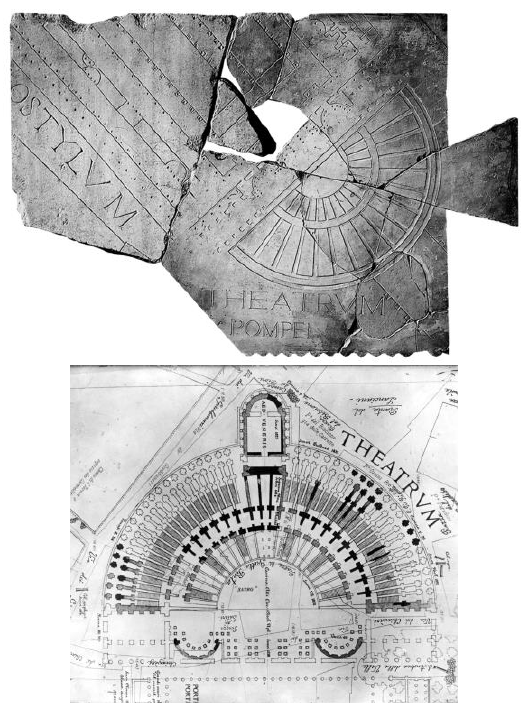
Figures 3 - 4. The Forma Urbis gives us only an approximation of the form of the theater of Pompey. The Victorious Venus temple does not appear in the drawing. In the relief and plan of the Lanciani, the presence and permanence of the temple in the block appears